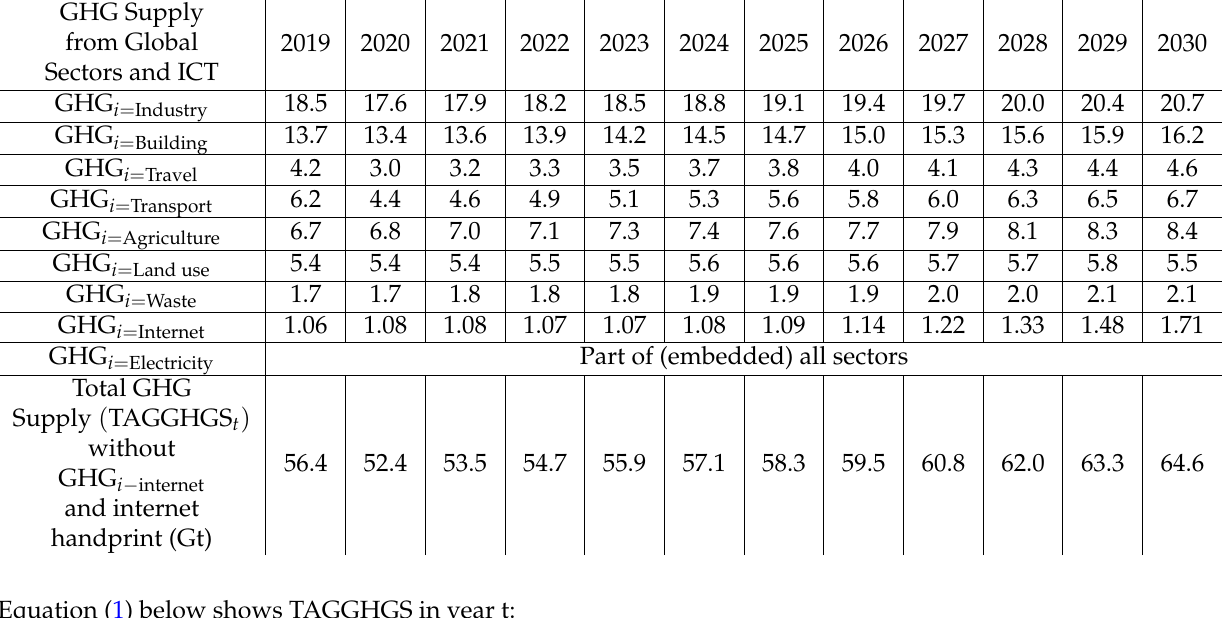
Table 2. Estimation of total anthropogenic global GHG supply (Gigatonnes) by Sector